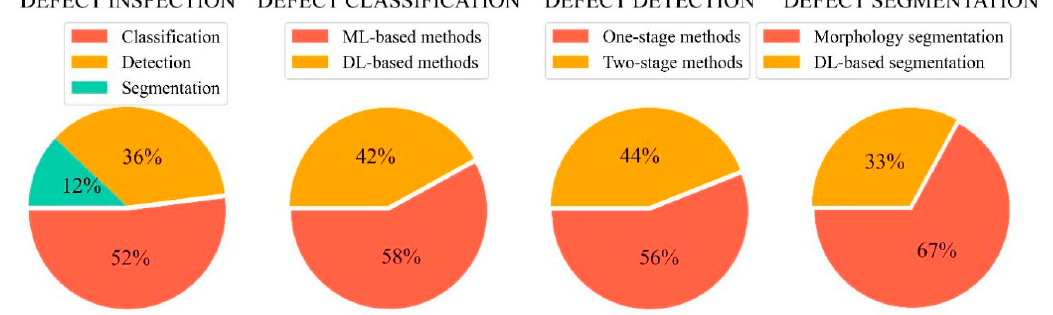
Figure 4. The classification map of the existing algorithms for each category. The dotted boxes rep- resent the main stages of the algorithms.